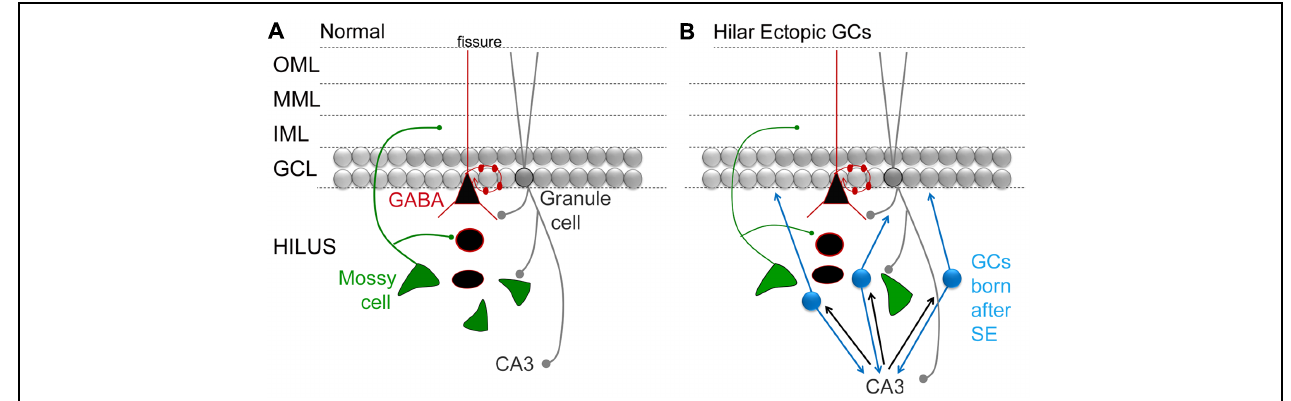
FIGURE 3 | Circuitry in the DG that involves MCs and adult-born GCs. (A) A simplified view of DG circuitry shows major pathways of MCs (green), perisomatic targeting cells (e.g., basket cells; black triangle outlined in red) and granule cells (gray circles). MCs innervate local GABAergic neurons with dendrites in the hilus. They also innervate GC proximal dendrites in the IML. Basket cells form a basket like axon plexus around GC somata. GCs innervate hilar neurons and area CA3 neurons. OML, outer molecular layer; MML, middle